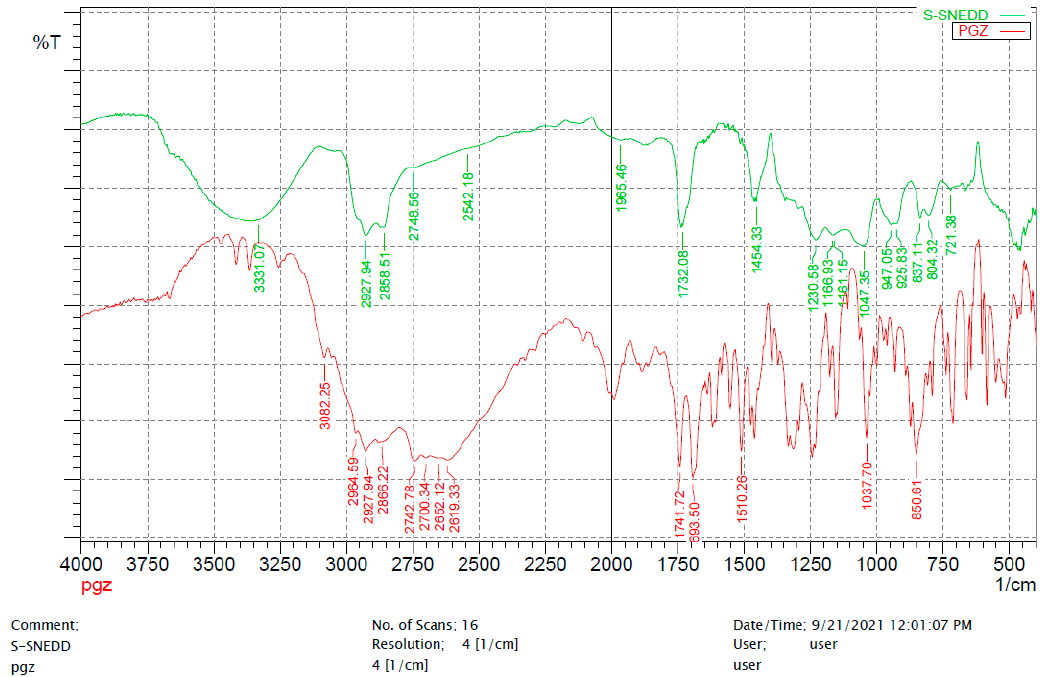
Figure 4. FTIR spectra of (a) PGZ loaded S-SNEDDS, (b) pure PGZ. Abbreviations: FTIR, Fourier- transform infrared spectroscopy; S-SNEDDS, solidified self-nanoemulsifying drug delivery system; PGZ, Pioglitazone Hydrochloride.